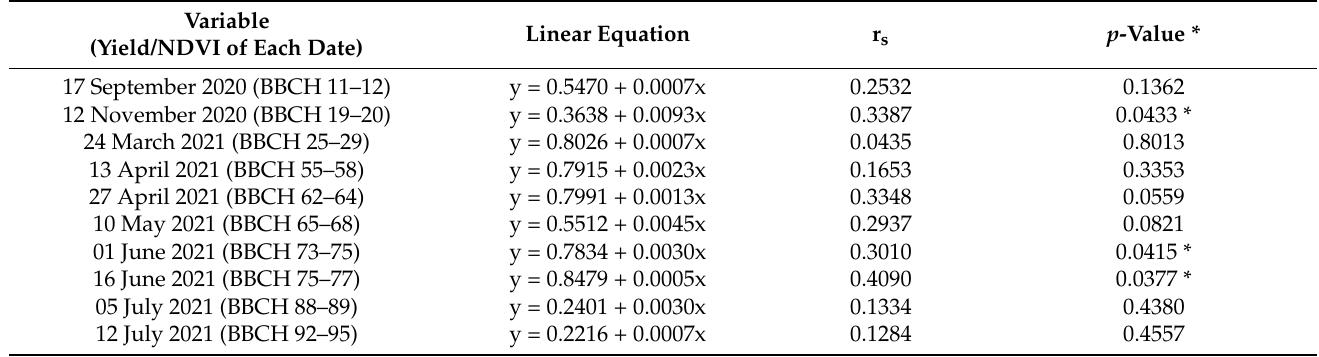
Table 6. Spearman’s rank correlation coefficient between final yield and normalized difference vegetation index (NDVI) values of each flying date during winter oilseed rape growing season of